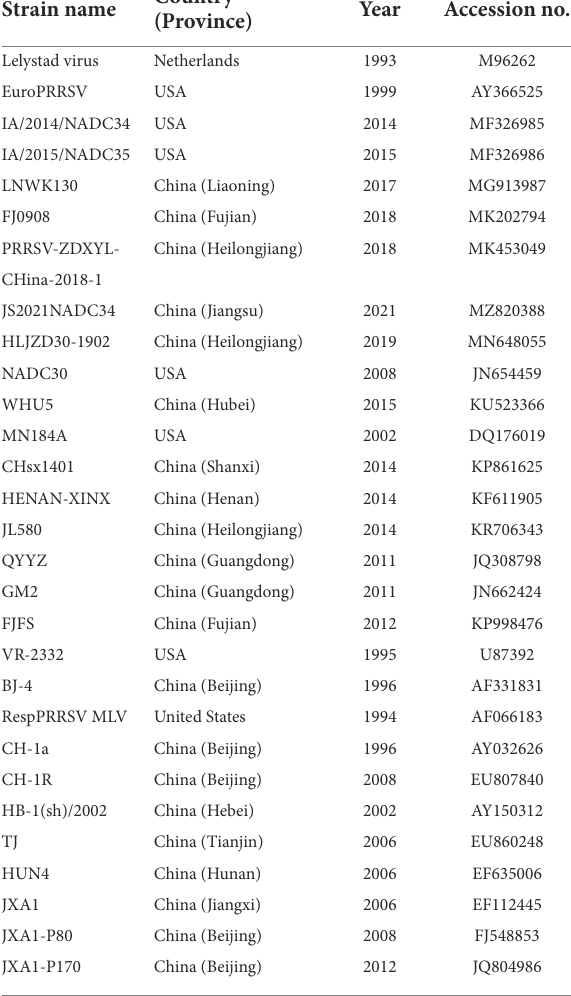
TABLE 3 Information about 29 PRRSV reference strains used in the sequence and phylogenetic